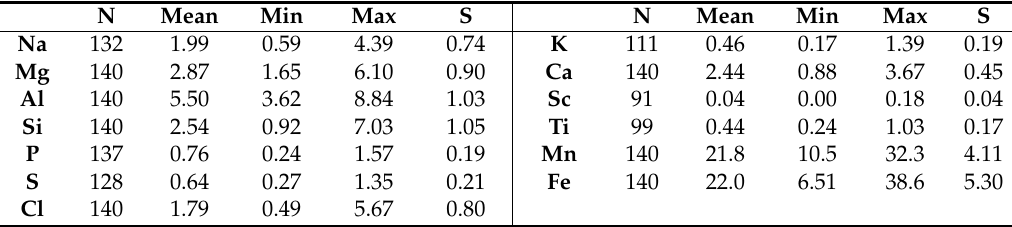
Table 3. Statistics for chemical composition of the Group 1 FeMn mineral association from scanning electron microscope/energy dispersive X-ray spectrometer (SEM/EDS), in wt